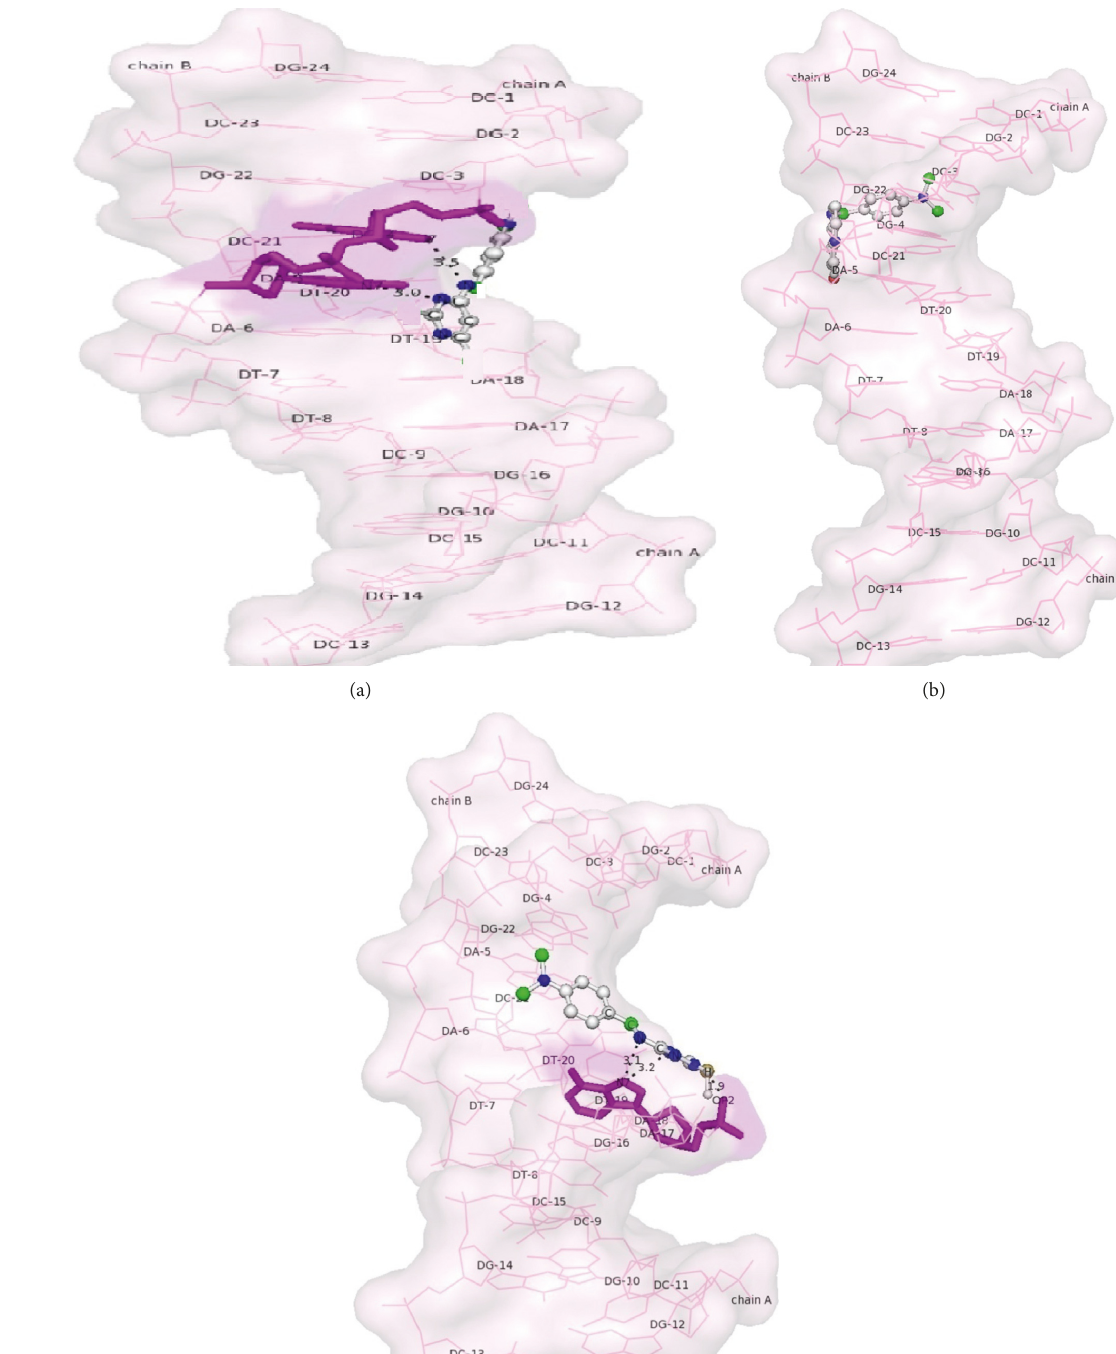
Figure 6: Molecular docked model of the heterocyclic Schiff base derivatives 3 (a), 4 (b), and 5 (c) with